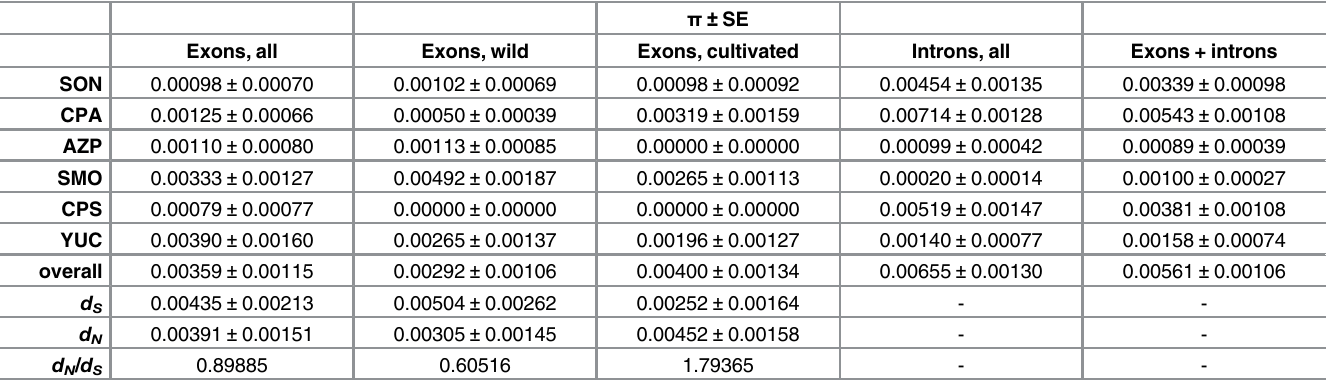
Table 2. Genetic diversity of pvr2/eIF4E1 .